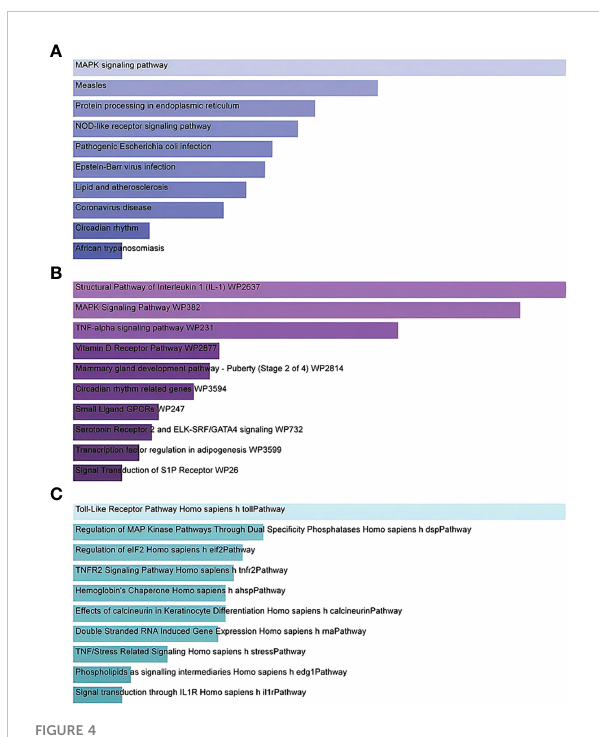
FIGURE 4 Bar graphs showing pathway enrichment analysis of DEGs shared by SARS-CoV-2, AKI, and CKD as performed by Enricher: (A) KEGG 2019 human pathway, (B) WikiPathways, and (C) BioCarta. Each bar represents a pathway in KEGG/WikiPathways/BioCarta. DEGs, differentially expressed genes; SARS-CoV-2, severe acute respiratory syndrome coronavirus 2; AKI, acute kidney injury; CKD, chronic kidney disease; KEGG, Kyoto Encyclopedia of Genes and